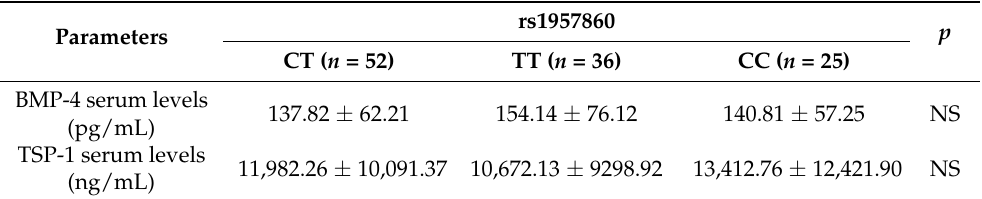
Table 4. TSP-1 and BMP-4 serum levels and BMP-4